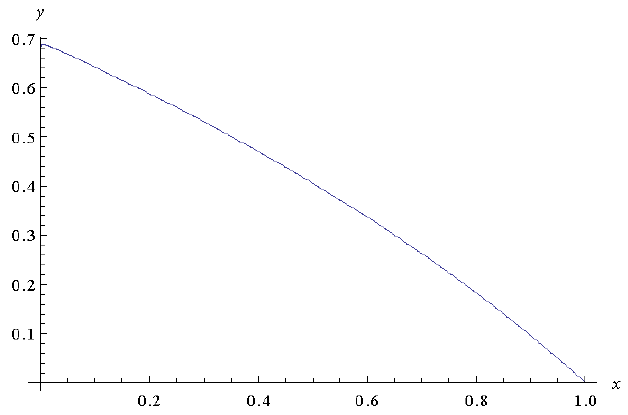
Figure 4. The approximate solution y for (cid:101) =